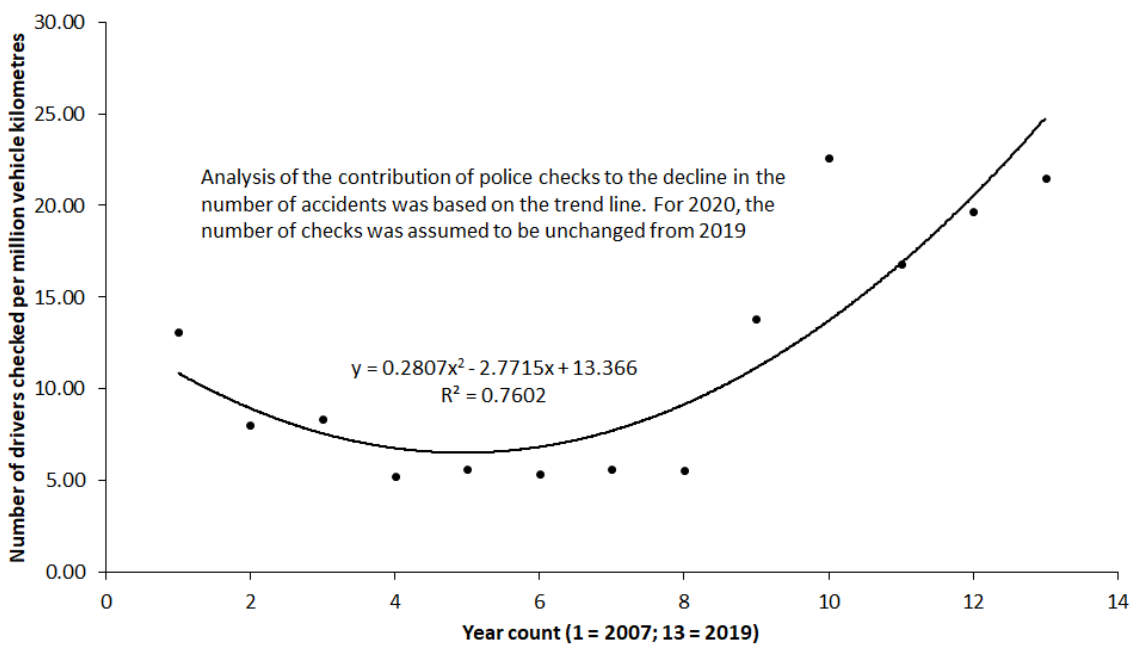
Figure 4 Police checks of drivers of heavy goods vehicles